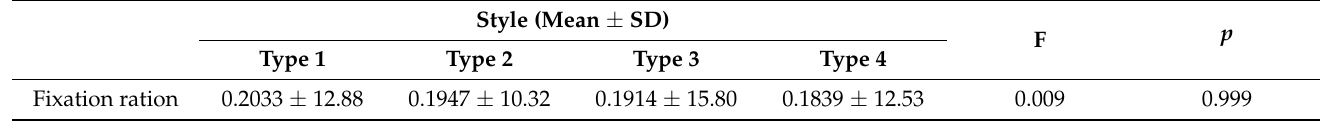
Table 15. Analysis of variance for different styles of button fixation time.